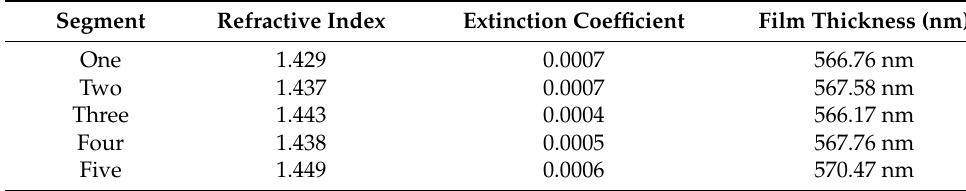
Figure 6. Transmission spectra of SiO 2 thin film deposited on different segments from one to five. Table 1. Optical constants of SiO 2 thin films with different segments. Table 1. Optical constants of SiO 2 thin films with different segments.